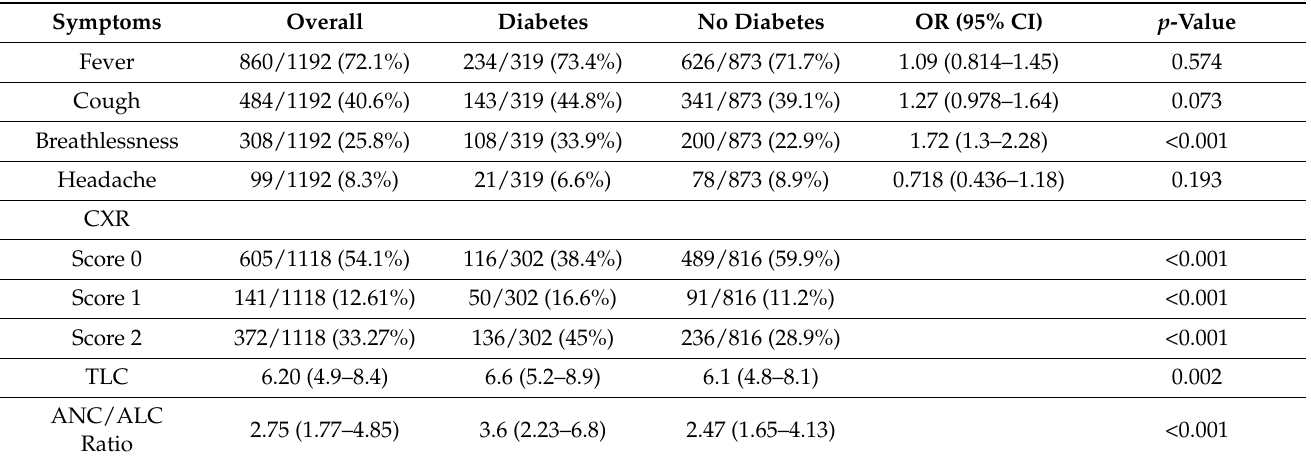
Table 2. Clinical, radiological, and laboratory parameters in patients with and without